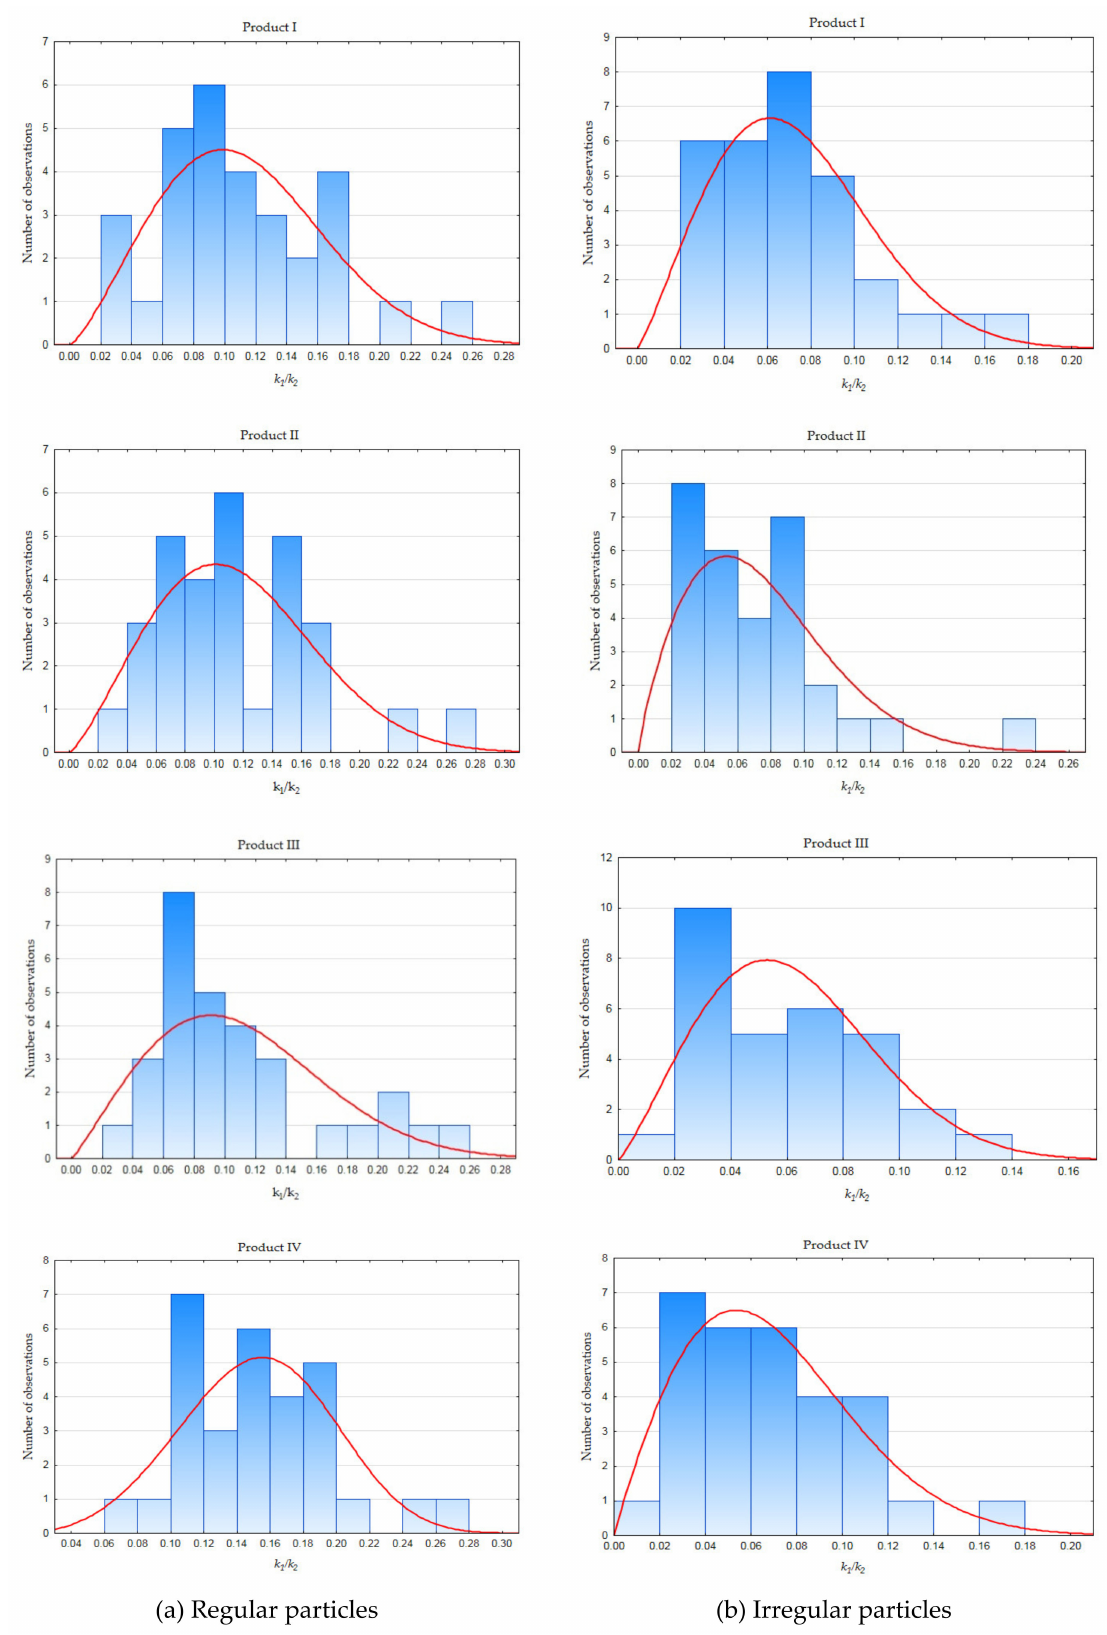
Figure 6. Histograms of the distribution of the ratio between the shape coe ffi cients k 1 / k 2 in products of separation of the regular and irregular particles separated into four